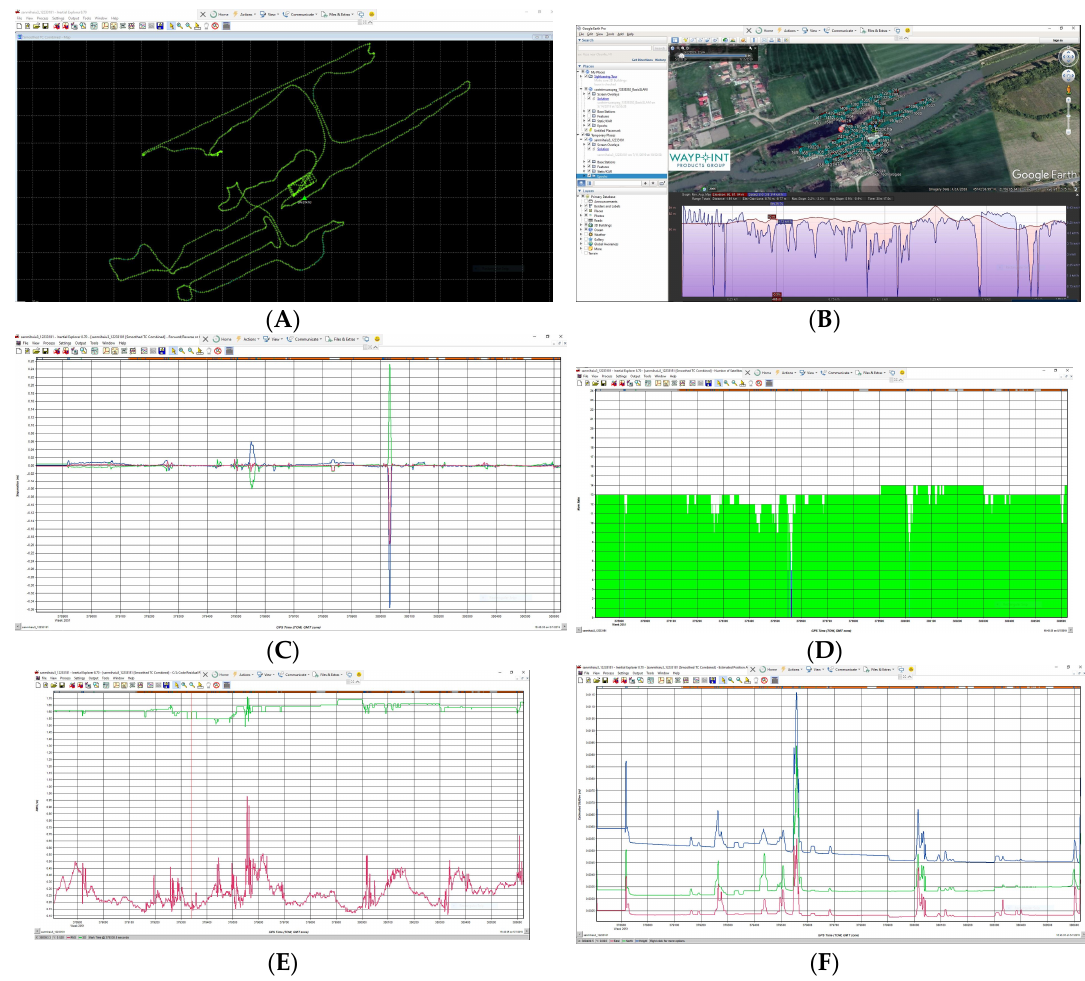
Figure 8. ( A ) Presentation of the scanning trajectory; ( B ) View the trajectory in Google Earth; ( C ) View the Correctness of the Scan (Combined Separation); ( D ) Number of visible satellites at the time of scanning; ( E ) RMS values; ( F ) Estimation of data accuracy (X, Y, Z and Time) for the S â nmihaiu Rom â n Hydro technical Node on 2 May